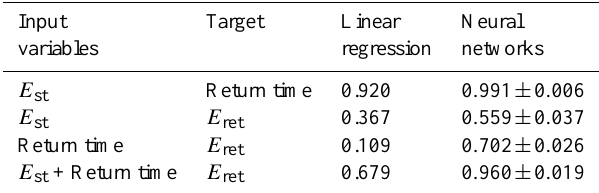
Table 1. Performance of linear and NN predictions on the test sets summarised in terms of the linear correlation coefficient R between targets and